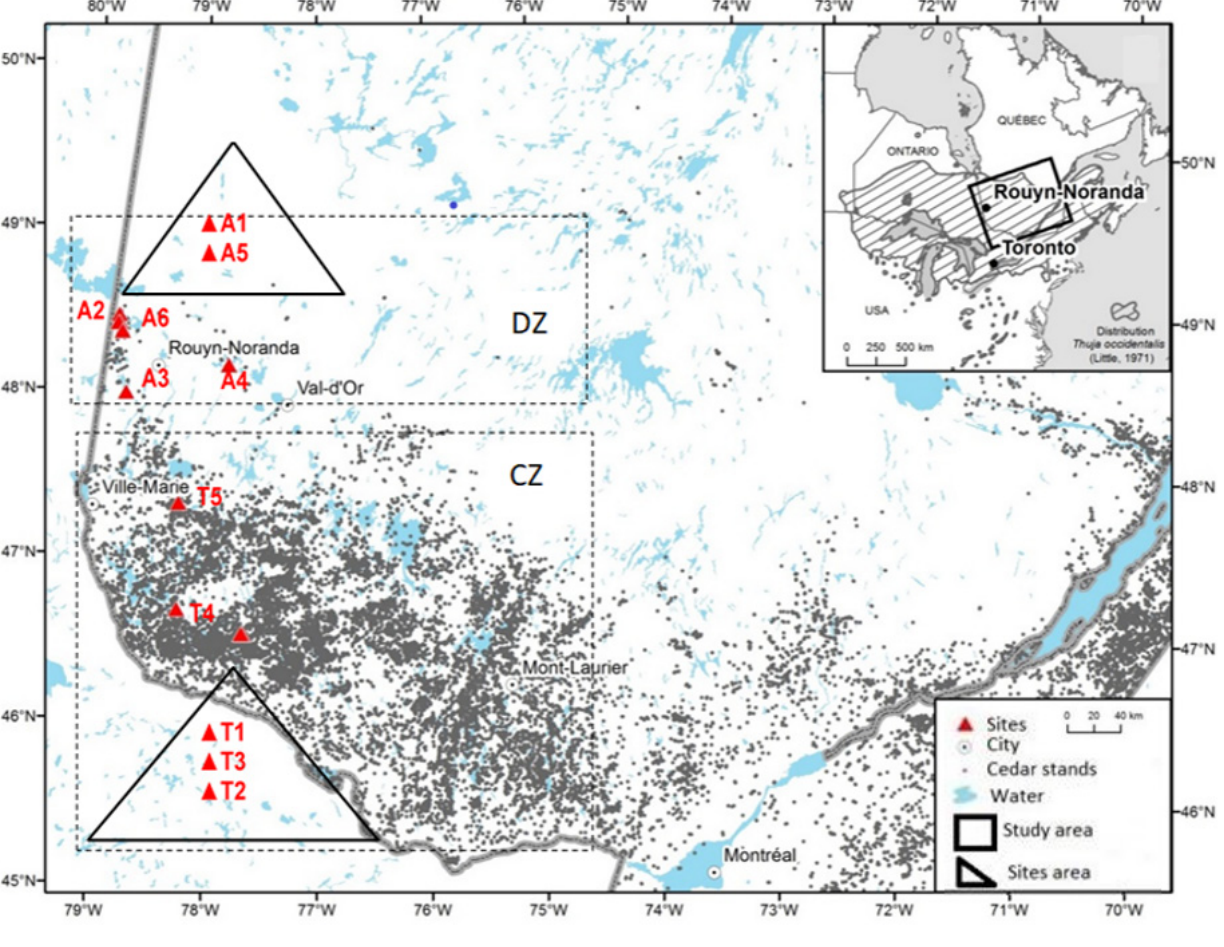
Figure 1. Locations of Thuja occidentalis sample sites (doted in red) in the Abitibi-Témiscamingue, Québec, Canada. Sampling sites were stratified between the continuous zone of distribution (CZ) and the discontinuous zone (DZ) [32].